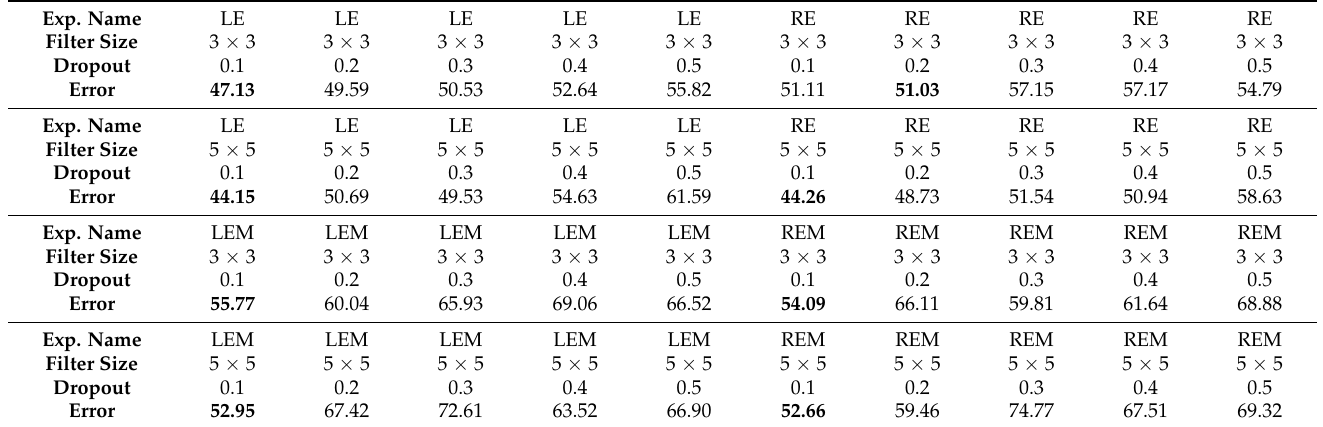
Table 4. Results of LE and RE with and without a mask (learning rate = 0.01).